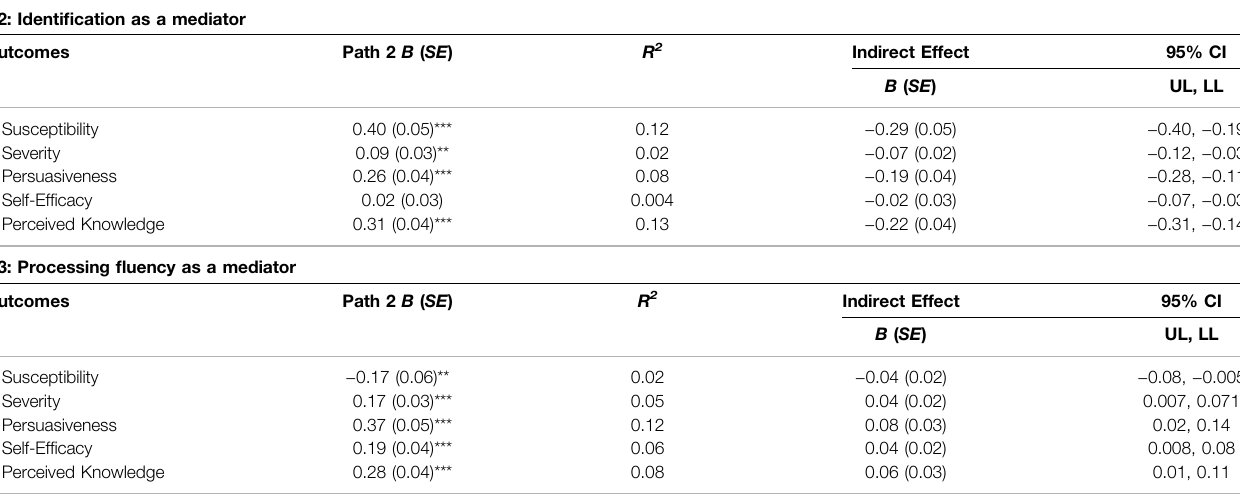
TABLE 1 | Results from the mediation analyses for hypotheses 2 and